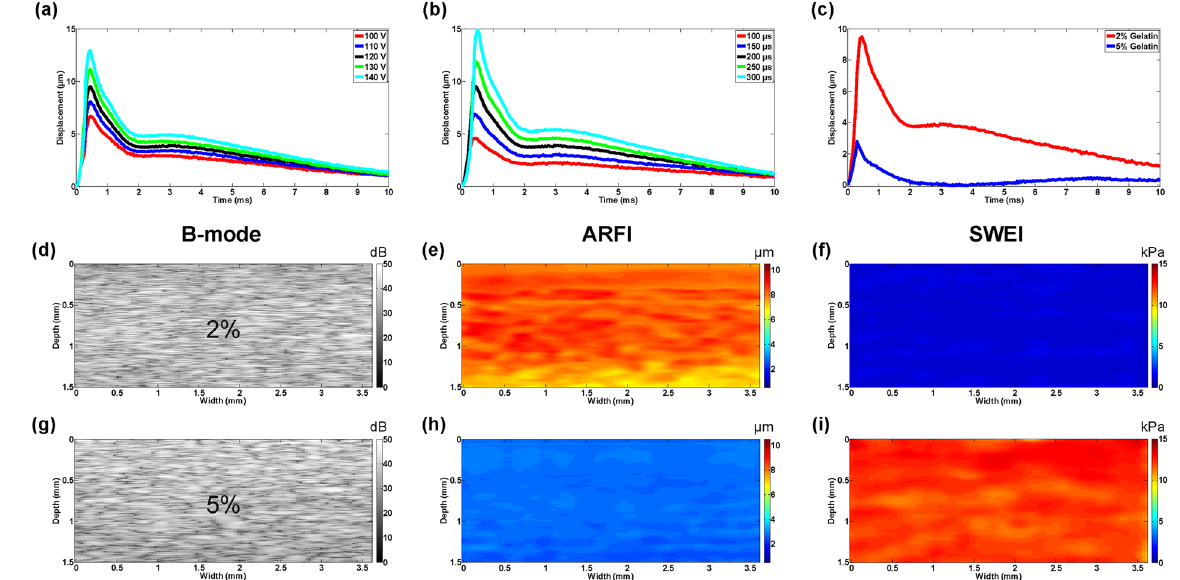
Figure 1. Imaging system validation on homogeneous gelatin phantom. ( a – c ) Dynamic displacement curves under different excitation voltage/excitation duration and phantom stiffness. B-mode/ARFI/SWEI images of homogeneous phantom at ( d – f ) 2% gelatin concentration, ( g – i ) 5% gelatin concentration.